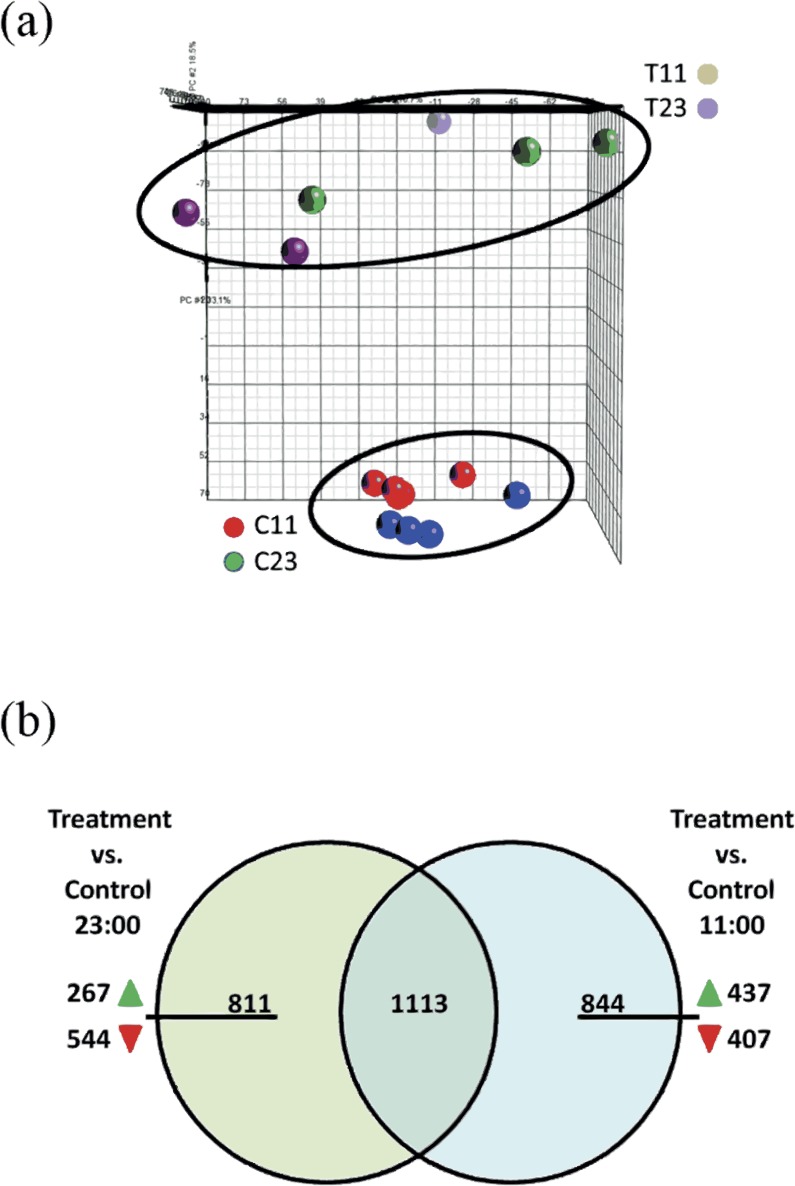
(A) Principle component analysis (PCA) map of samples from control 11:00, control 23:00, treated 11:00, and treated 23:00 (C11, C23, T11, and T23, respectively). The samples were applied to the PCA function of Partek. Analysis show distinct separation between treated and control samples. (B) Venn diagram representing the overlap of the total of 2,768 genes of the total 2,768 differentially expressed genes at treatment samples from 11:00 and from 23:00.Among the 844 unique genes that were significantly up- or down-regulated expression during the day, 437 were showed up-regulation of their expression and 407 were down-regulated. Among the 811 unique genes that were significantly up- or down-regulated expression during the night, 267 were showed up-regulation of their expression and 544 were down-regulated.